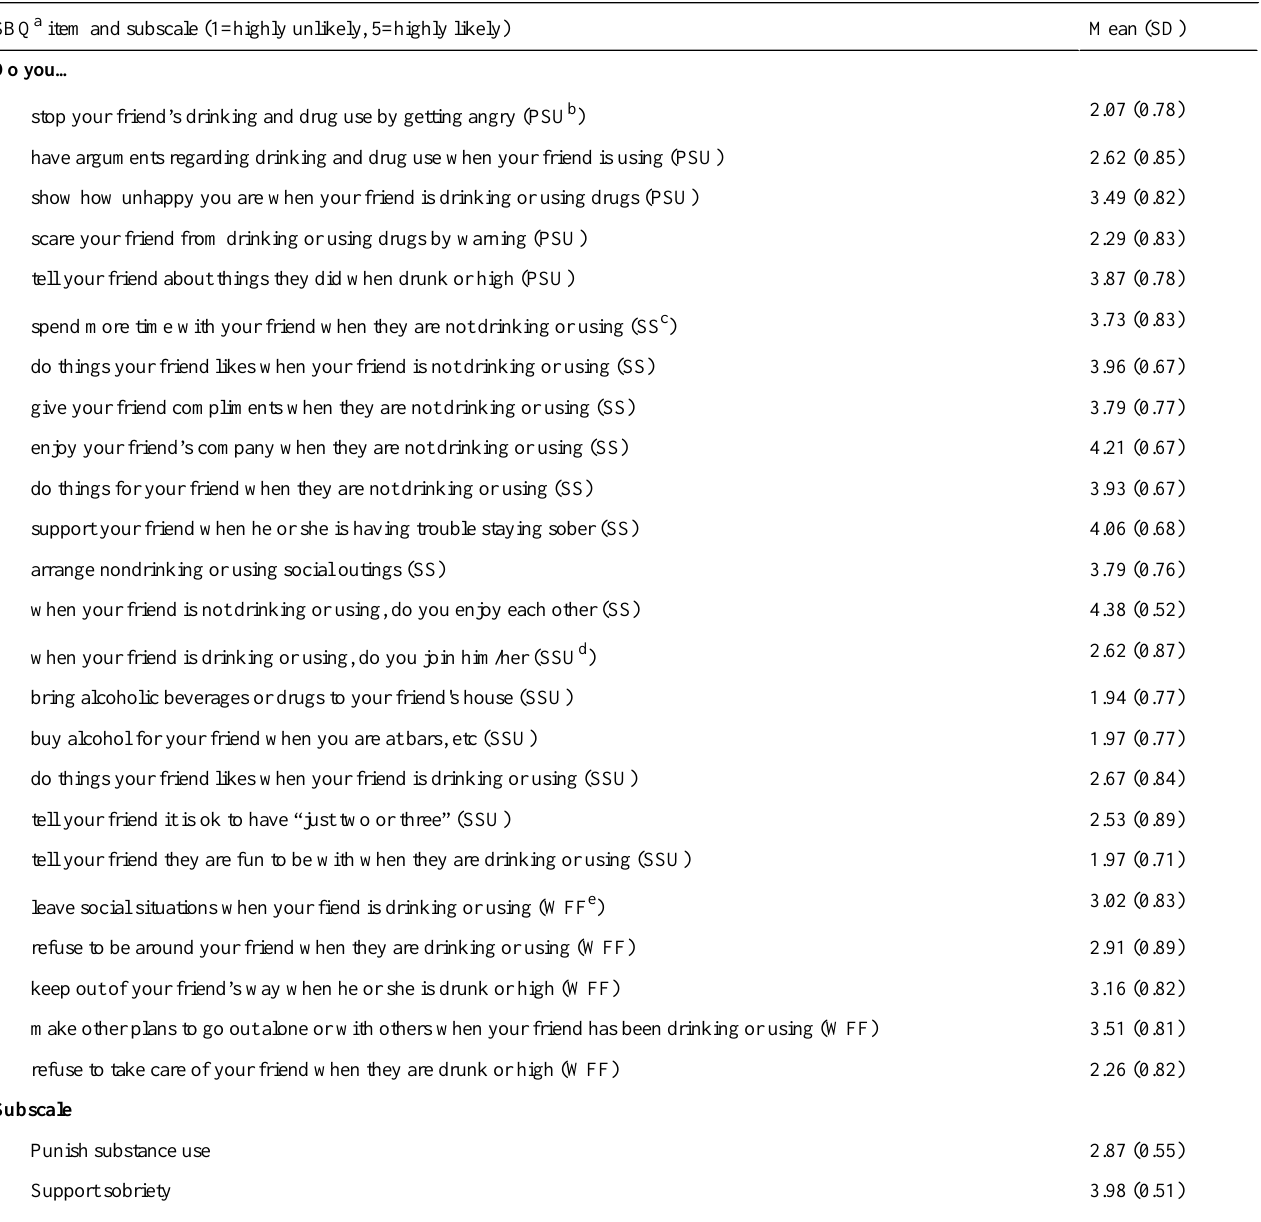
Table 2. Peer Significant Other Behavior Questionnaire subscale responses to friend’s substance use